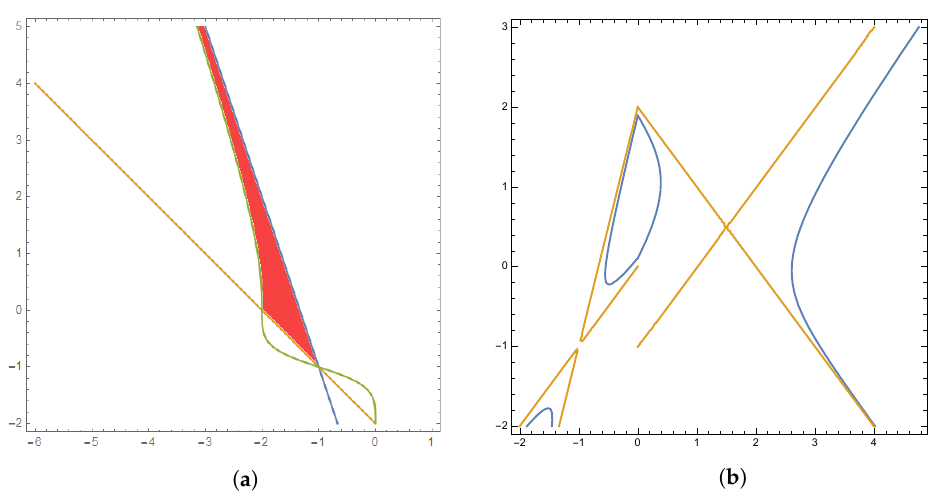
Figure 6. ( a ) Region with limit cycle; ( b ) Limit cycle found for γ = − 2 and θ =